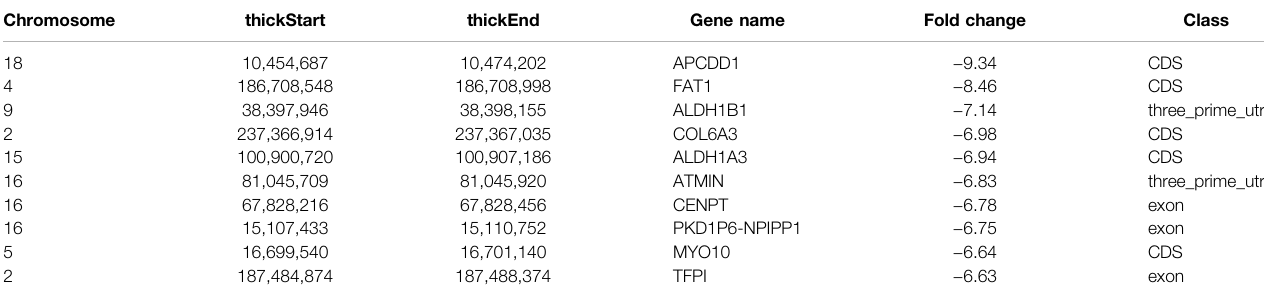
TABLE 6 | Top ten reduced methylation peaks.